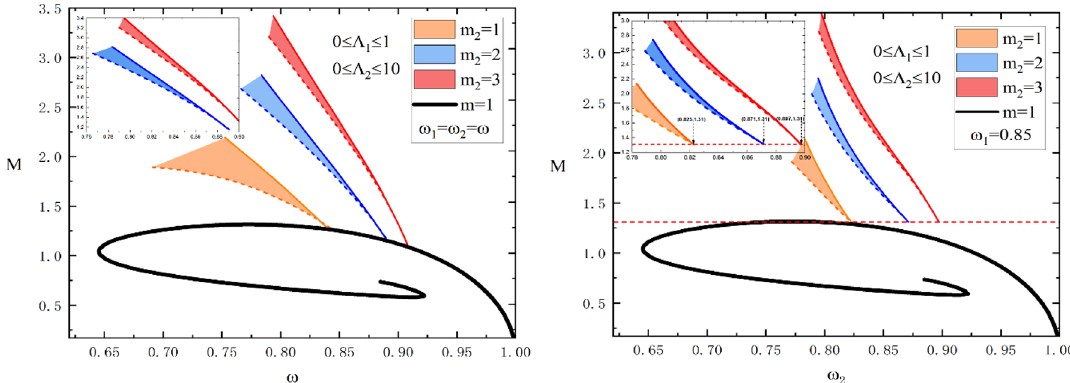
Figure 7 . Left : the mass M of the SIMBSs as a function of the synchronized frequency ω with the azimuthal harmonic indexes m 2 = 1 , 2 , 3 . Right : the mass M of the SIMBSs as a function of the nonsynchronized frequency ω 2 with ω 1 = 0 . 85 . The horizon red dashed line indicates the mass M = 1 . 31 . In both panels, the shaded regions corresponds to 0 ≤ Λ 1 ≤ 1 and 0 ≤ Λ 2 ≤ 10 . The black spiral curve indicates the ground state with m = 1 and all solutions have µ 1 = 1 , µ 2 = 0 . 93 , m 1 = 1